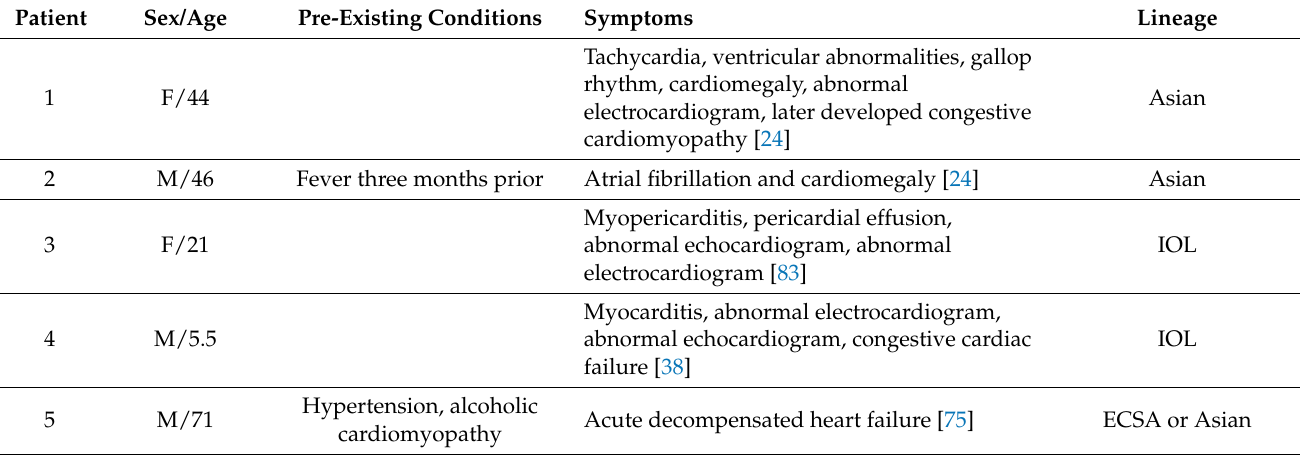
Table 2. Cardiac complications from individual patients infected with CHIKV. Lineage was determined from the data in the case studies when available. When the lineage was not reported, the year and location was matched to isolates in NCBI Nucleotide with Table 1 to deduce the lineage. NR = not reported, CABG = coronary artery bypass